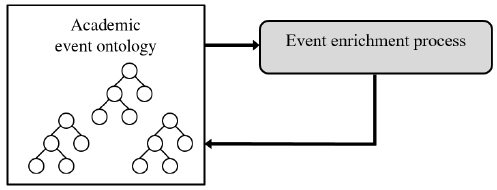
Figure 6. Enrichment process for event ontological